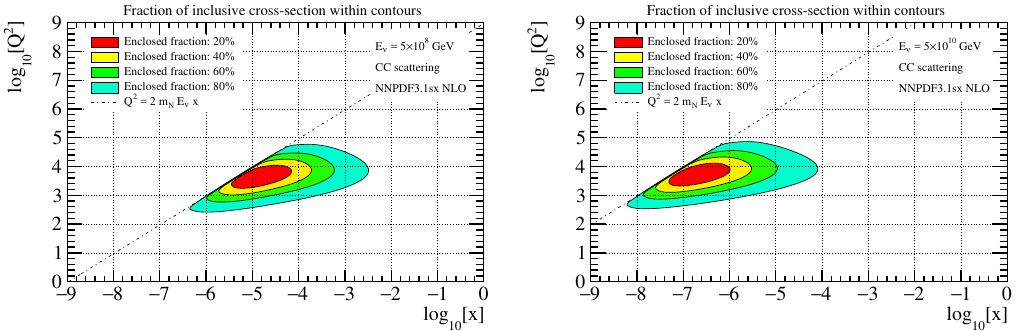
Figure 2 . The percentage of the total UHE neutrino-isoscalar cross-section corresponding to the contribution of di(cid:11)erent kinematic regions in the ( x; Q 2 ) plane in CC scattering. Predictions are computed in the FONLL scheme at NLO using the NNPDF3.1sx NLO PDF set. Results are shown for E (cid:23) = 5 10 8 GeV (left) and E (cid:23) = 5 10 10 GeV (right). The dot-dashed diagonal lines (cid:2) (cid:2)